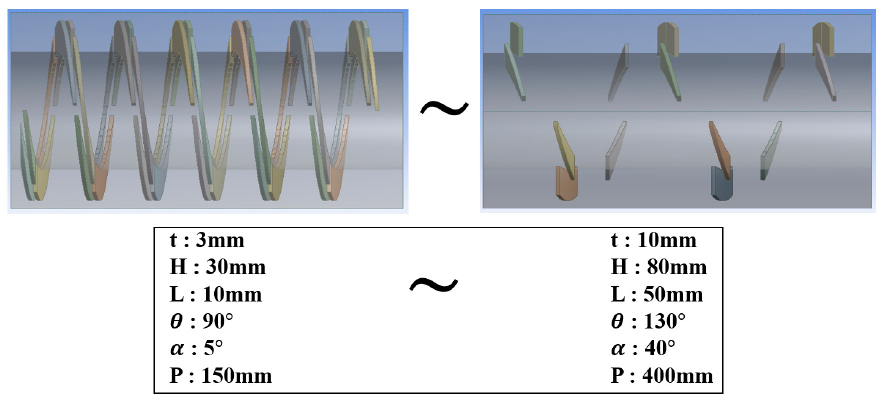
Figure 17. Ranges of design parameters relating to blade gap.